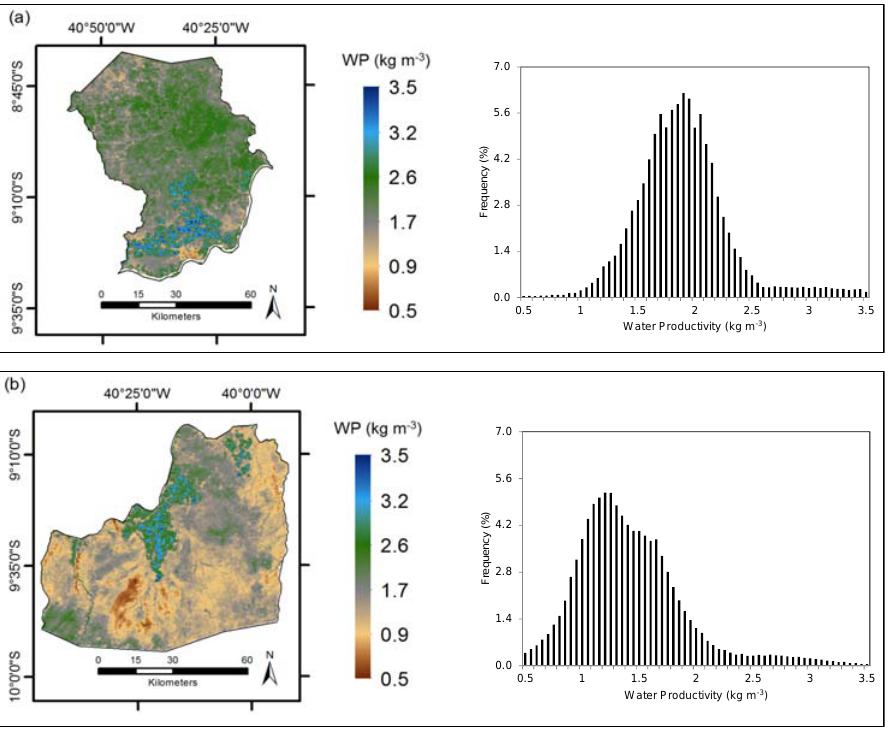
Figure 8. Annual values and histograms of water productivity (WP) in the Brazilian semi-arid agricultural growing regions: ( a ) Petrolina municipality, Pernambuco (PE) state; ( b ) Juazeiro municipality, Bahia (BA)